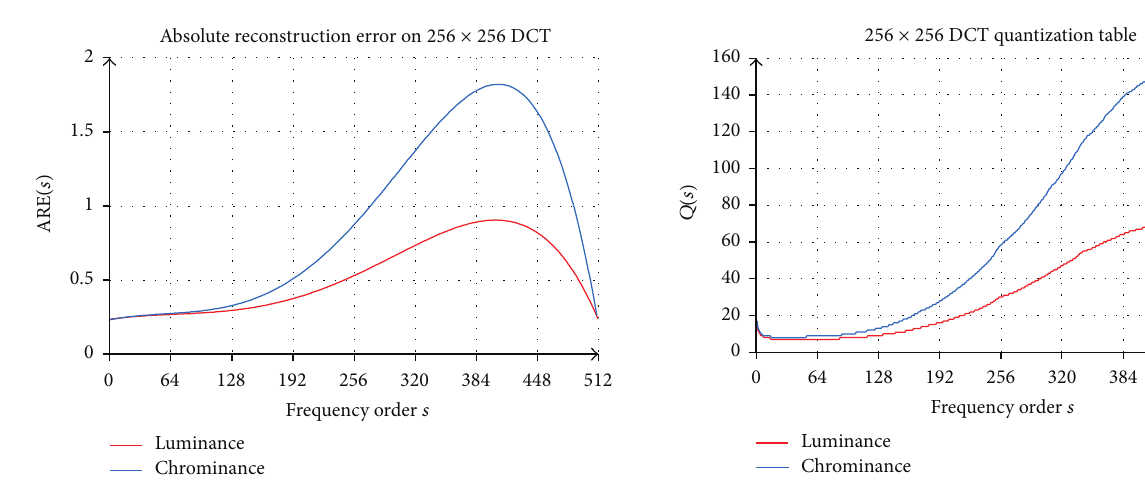
Figure 4: Average absolute reconstruction error of incrementing DCT coefficients on 256 × 256 DCT luminance and chrominance for 40 real images.